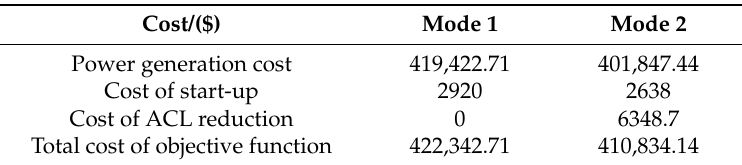
Table 4. Optimal scheduling cost